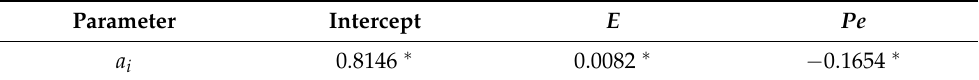
Table 5. Third attempt of the regression analysis to estimate the coefficients, a i , using the linear least-squares approach. Asterisk ( ∗ ) indicates the statistical significance of the coefficient using a t-test with a 95% confidence interval. Other statistics: R 2 = 0.746, Adjusted R 2 = 0.737, F-statistic = 83.61, P(F) = 0.0. Condition number =